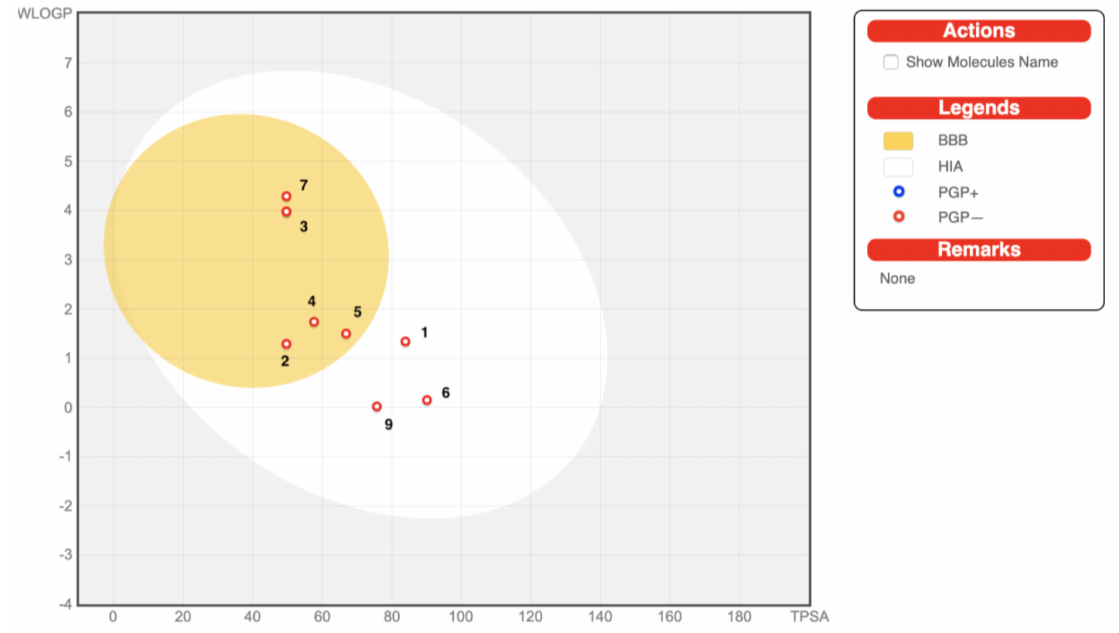
Figure 8. BOILED-Egg plot of compounds 1–9 with excellent description of the three-dimensional quantitative structure-activity relationship (3D-QSAR) model and the best ICM score values. Points located in the BOILED-Egg yolk (yellow) represent molecules predicted to passively permeate through the blood-brain barrier (BBB), whereas points in the egg white are predicted to be passively absorbed by the gastrointestinal tract (HIA). Blue dots (PGP + ) indicate the molecules expected to be e ffl uated from the central nervous system (CNS) by P-glycoprotein, whereas the red ones (PGP-) indicate the molecules predicted not to be e ffl uated from the CNS by